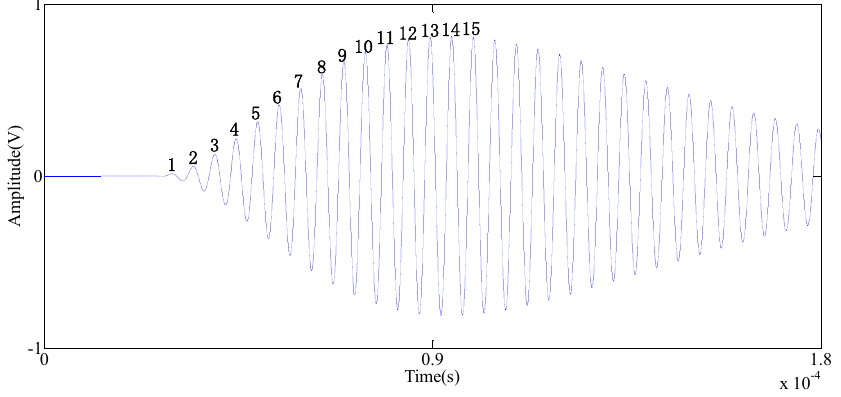
Figure 4. Simulation waveform of ultrasonic signal.